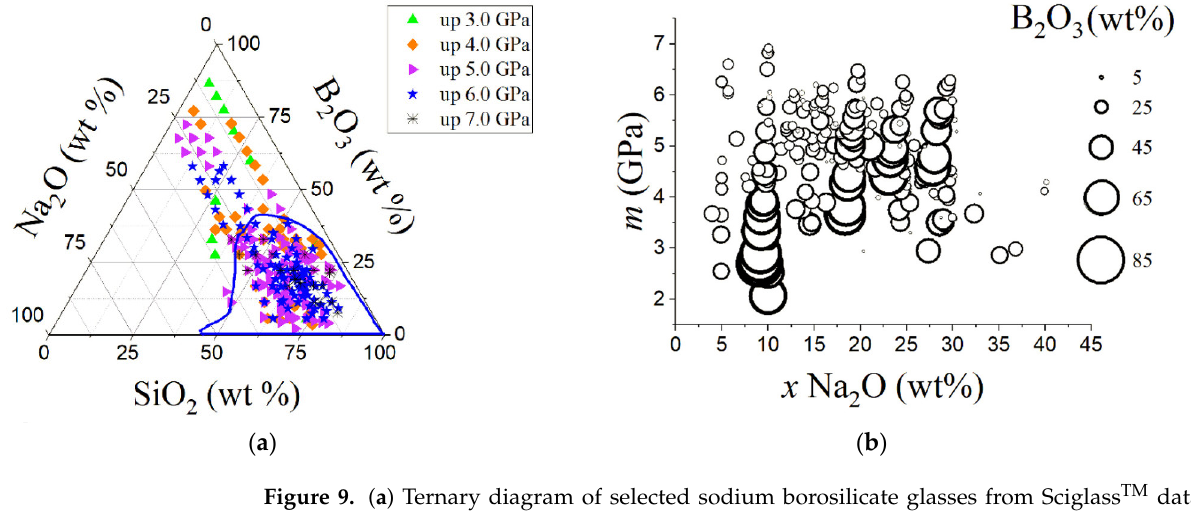
Figure 9. ( a ) Ternary diagram of selected sodium borosilicate glasses from Sciglass TM database (version 7.9). The blue region corresponds to approximately the microhardness behavior from a plethora of sodium borosilicate waste-immobilization glasses. ( b ) The microhardness dependence on sodium oxide content at 10 2 Pa · s. Microhardness depends strongly on the amount of sodium and boron contents.